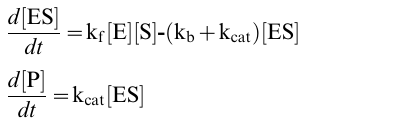
Figure S1 Models of PKA and CaMKII activation